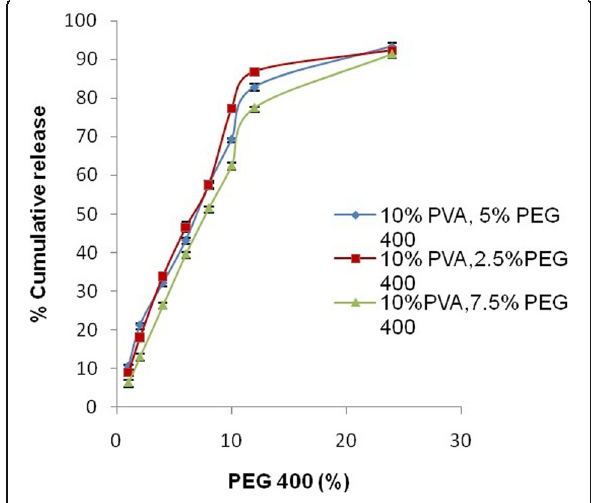
Fig. 7 In vitro drug release from hydrogel sheets